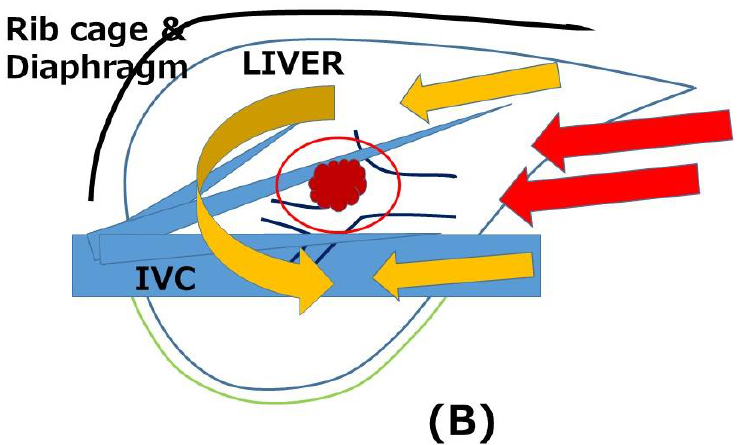
Figure 1. Open ( A ) and laparoscopic “caudal approach” ( B ) repeat liver resections. The directions of view and manipulation in each approach are indicated with red arrows. ( A ) In the open approach, the subphrenic rib cage was opened with a large subcostal incision and the liver was mobilized (lifted) from the retroperitoneum. ( B ) In laparoscopic approach, the instruments were introduced into the cage from the caudal direction and the surgery was performed with minimal damage to the associated structures. Orange arrows indicate the dissection of adhesion. ( A ) Total adhesiolysis was performed in open procedure. ( B ) Direct approach (also indicated with orange arrows) to the tumor in laparoscopic “caudal approach” can facilitate surface repeat liver resection with minimal adhesiolysis. Table 1. Comparison between laparoscopic primary and repeat liver resection in terms of background factors and postoperative short-term